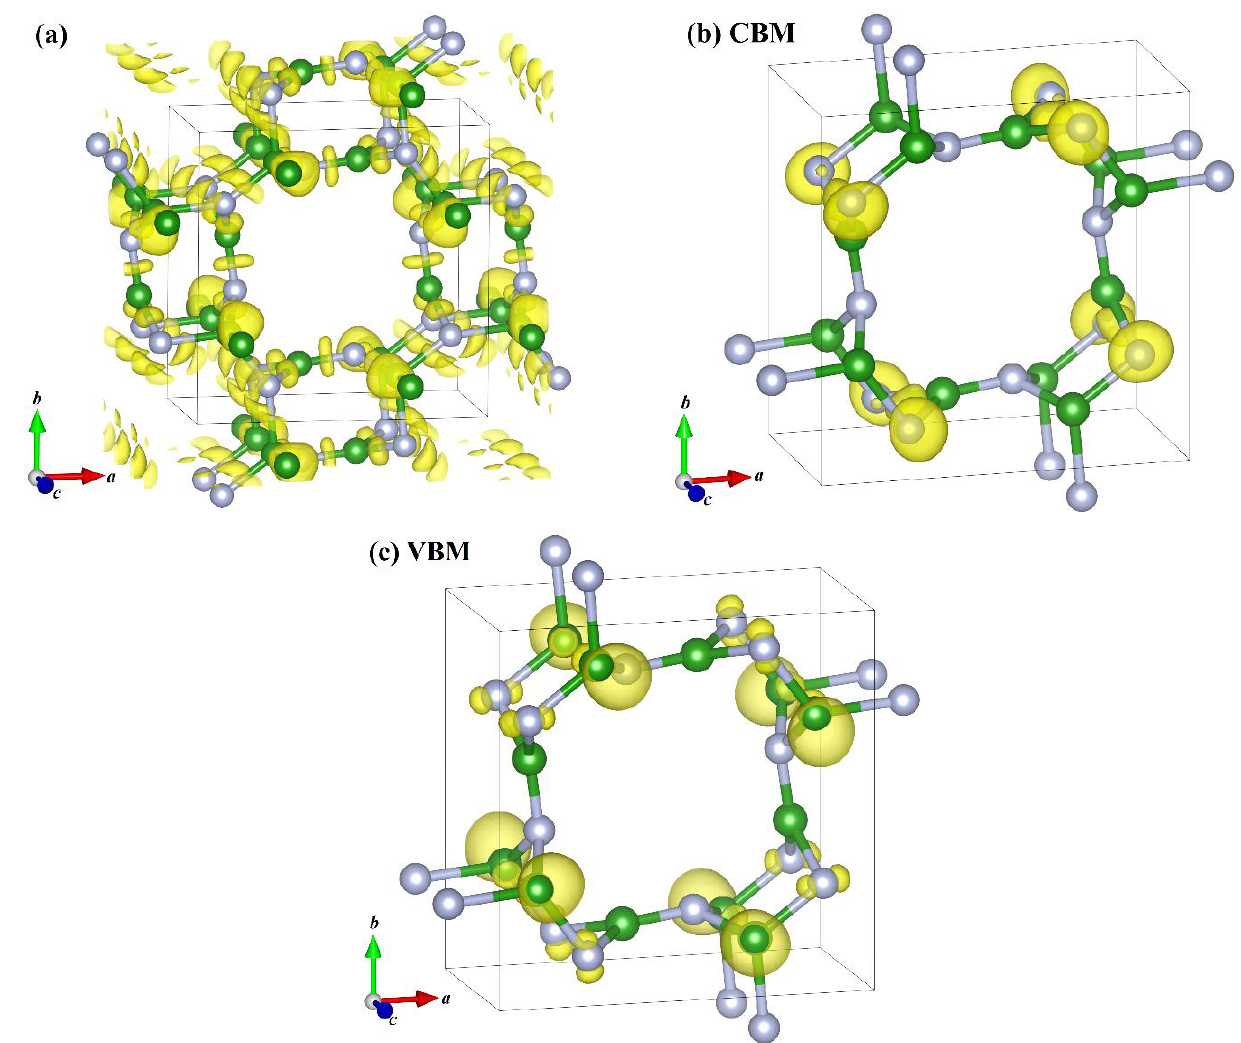
Figure 7. Electron localization functions with an isosurface level set to 0.88 ( a ), and band decomposed charge density (BDCD) for CBM ( b ) and VBM ( c ) of P 4/ m BN, the isosurface of the BDCD at the CBM and VBM was set to 0.005 eV/Å 3 .